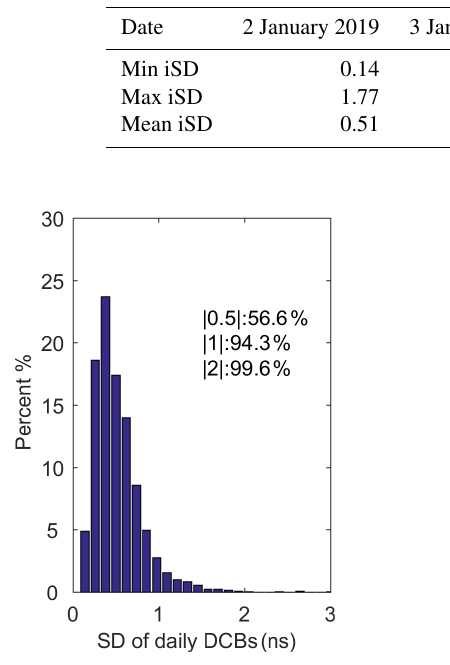
Figure 8. Statistical distribution of intraday SD of receiver DCB for all station in 30d.